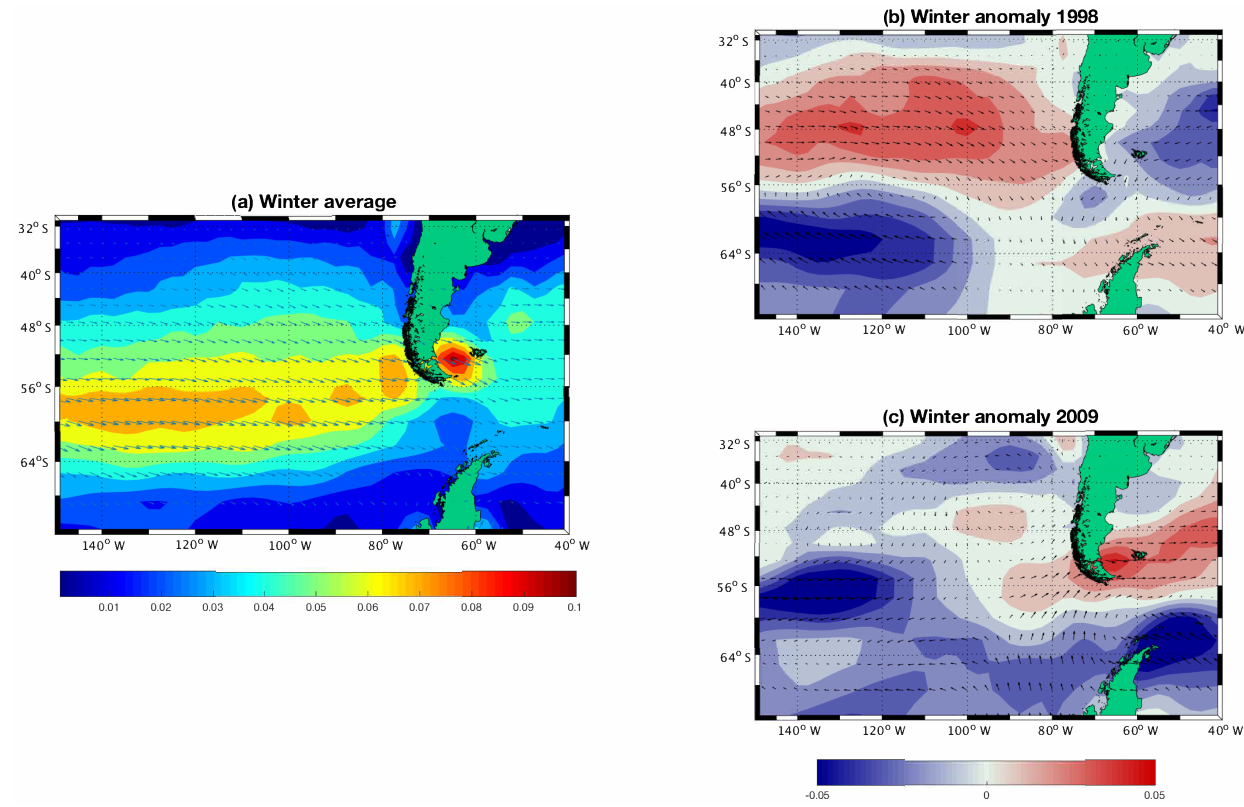
Figure 11. Maps of NCEP-NCAR (a) winter (July–September) mean wind stress in Pa (arrows; color indicates magnitude) for the time period 1998–2010. (b) Winter wind stress anomaly (Pa) for the year 1998. (c) Same as (b) but for 2009.